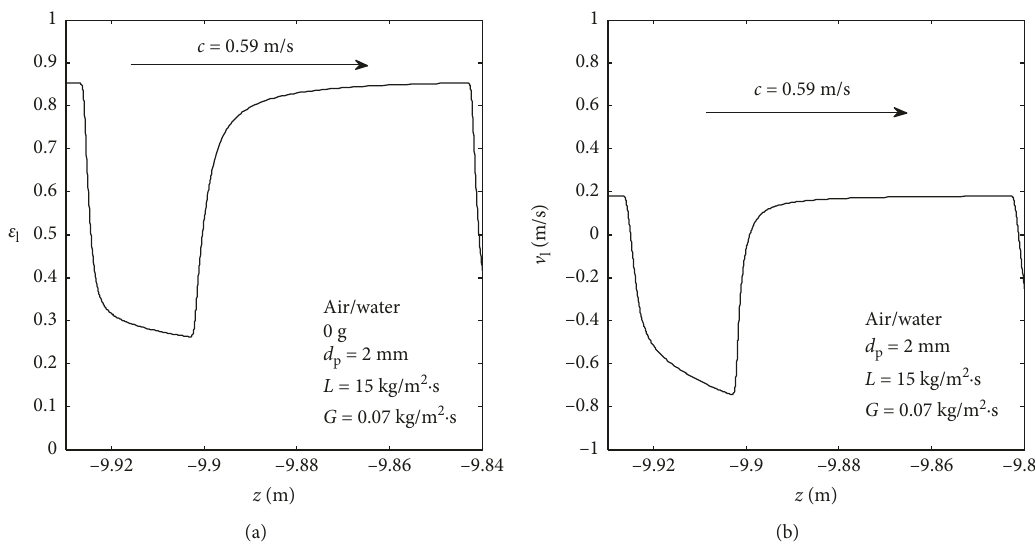
Figure 4: (a) A pulsing solution ( c 0.59m/s) for the liquid saturation from traveling wave analysis (same system as in Figure 2(b)). (b) A (cid:31) pulsing solution ( c 0.59 m/s) for the liquid velocity from traveling wave analysis (same system as in Figure 2(b)). (cid:31)